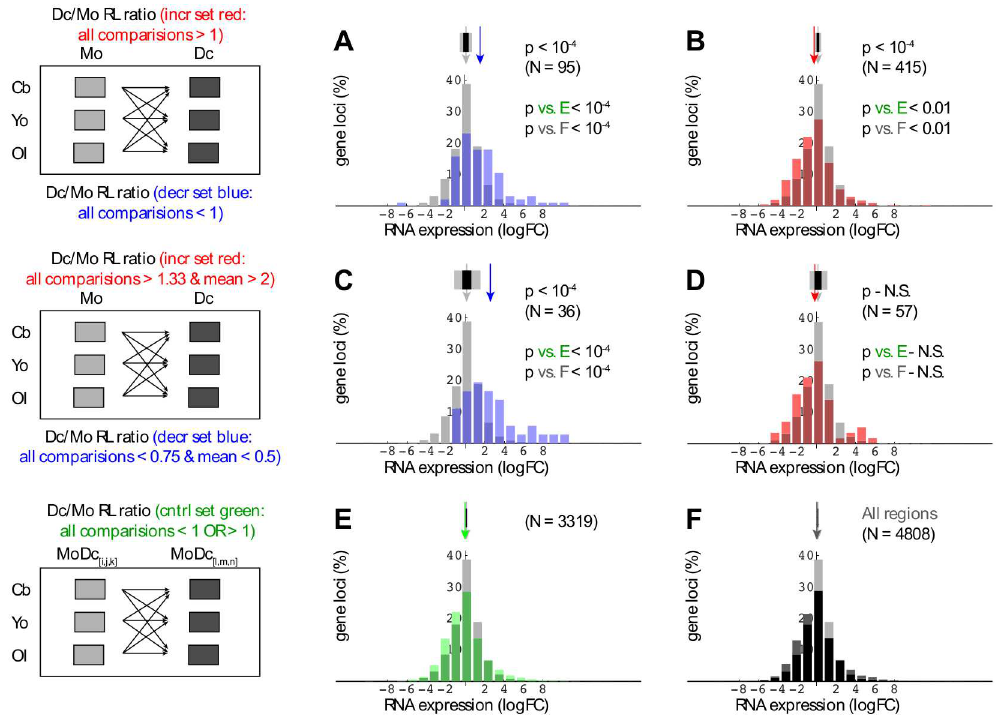
Fig 3. Inverse relationships between region span and differentiation-dependent gene expression change. Cord blood RNA-seq log fold change (logFC) values are presented as overlapping histograms, with explanatory schematics on left for rows AB, CD, and EF. For rows AB and CD, RL (region length) ratios were compared according to two criteria: i) all nine Mo/Dc RL ratios either exceeded the indicated ‘all comparisons’ filter threshold (increase set shown in red) or fell below the designated threshold (decrease set shown in blue), and ii) the mean of the same nine Mo/Dc RL ratios either exceeded or fell below the corresponding mean threshold value. In panel F, the black histogram shows values for genes where any part of the transcribed region overlapped at least one H3K27me3-enriched region. In each panel, the reference light gray histogram represents all gene loci (N = 23710) for which the data yielded measurable expression (min logCPM = -4.67). Arrows above histograms indicate median reference and subset expression values, while flanking (or overlapping) black and gray rectangles correspond to random sampling-derived p values of 0.005 and 10 −4 , respectively.